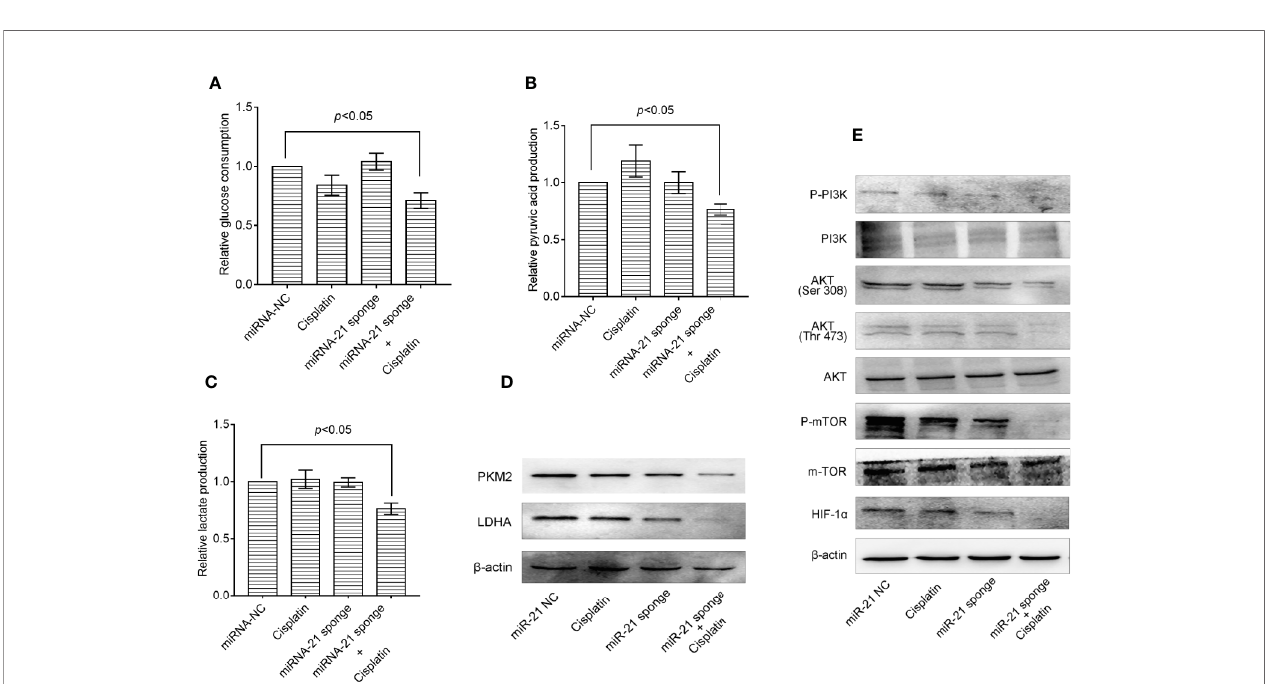
FIGURE 5 | Combination of miRNA-21 and cisplatin inhibits glycolysisin A549/DDP cells through the PI3K/AKT/mTOR/HIF-1 a signaling pathway. (A) Glucose consumption, (B) pyruvate production,and (C) lactate production were measured with miRNA-NC or miRNA-21 combined with cisplatin (IC 20 ) in A549/DDP cells. Western blot was used to determine the expression of (D) glucose metabolizingenzymes (PKM2andLDHA)and (E) PI3K/AKT/mTOR/HIF-1 a pathway enzymes under miRNA-NC or miRNA-21 combined with cisplatin (IC 20 ) inA549/DDP cells. The experiments were repeated at leastthree times and results were expressedas mean ± S.D. PI3K, Phosphoinositide 3-kinase; AKT, AKTserine/threonine kinase; mTOR, mechanistictarget of rapamycin; p, phosphorylated;HIF-1 a , hypoxia-induciblefactor-1 a